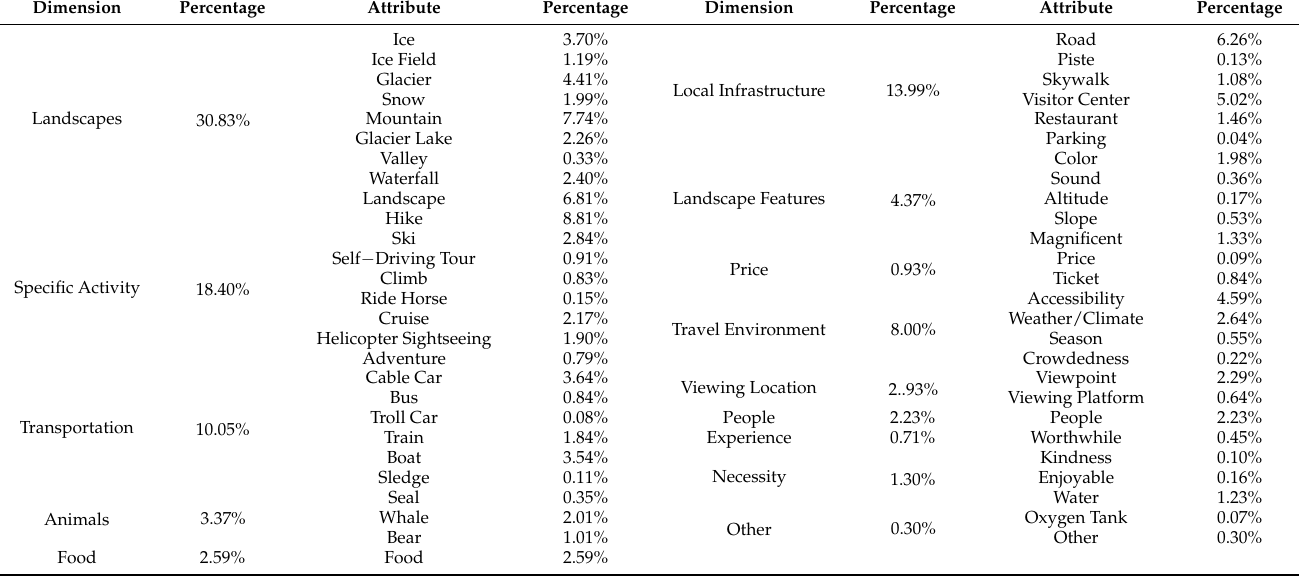
Table 2. Results of overall destination